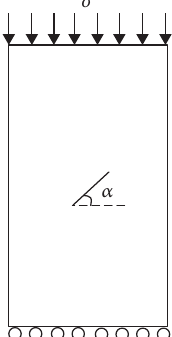
Figure 4: Geometrical parameters and loading conditions of rock specimen.